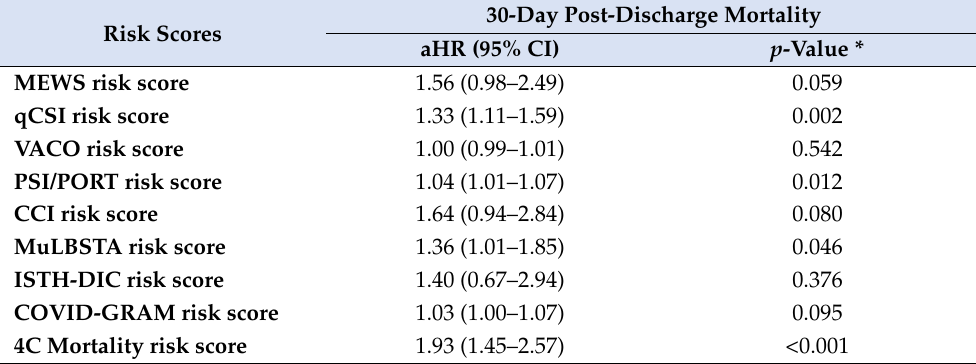
Table 4. Association of different risk scores with 30-day post-discharge mortality (multivariable Cox proportional hazards logistic regression